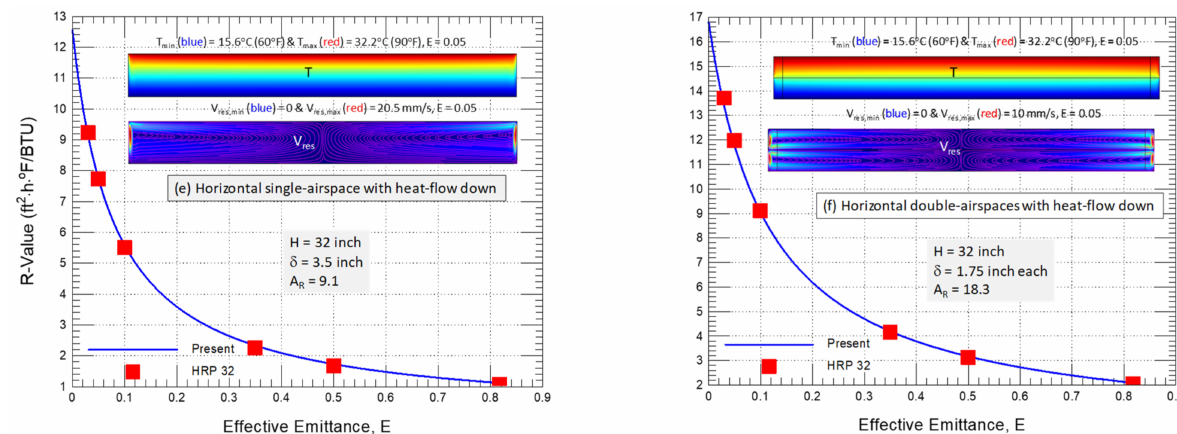
Figure 2. Model validation against HRP 32 test data [4] for single airspace of Aspect ratio of 9.1 and double airspaces of aspect ratio of 18.3 for a horizontal heat flow ( a , b ), an upward heat flow ( c , d ) and a downward heat flow ( e , f